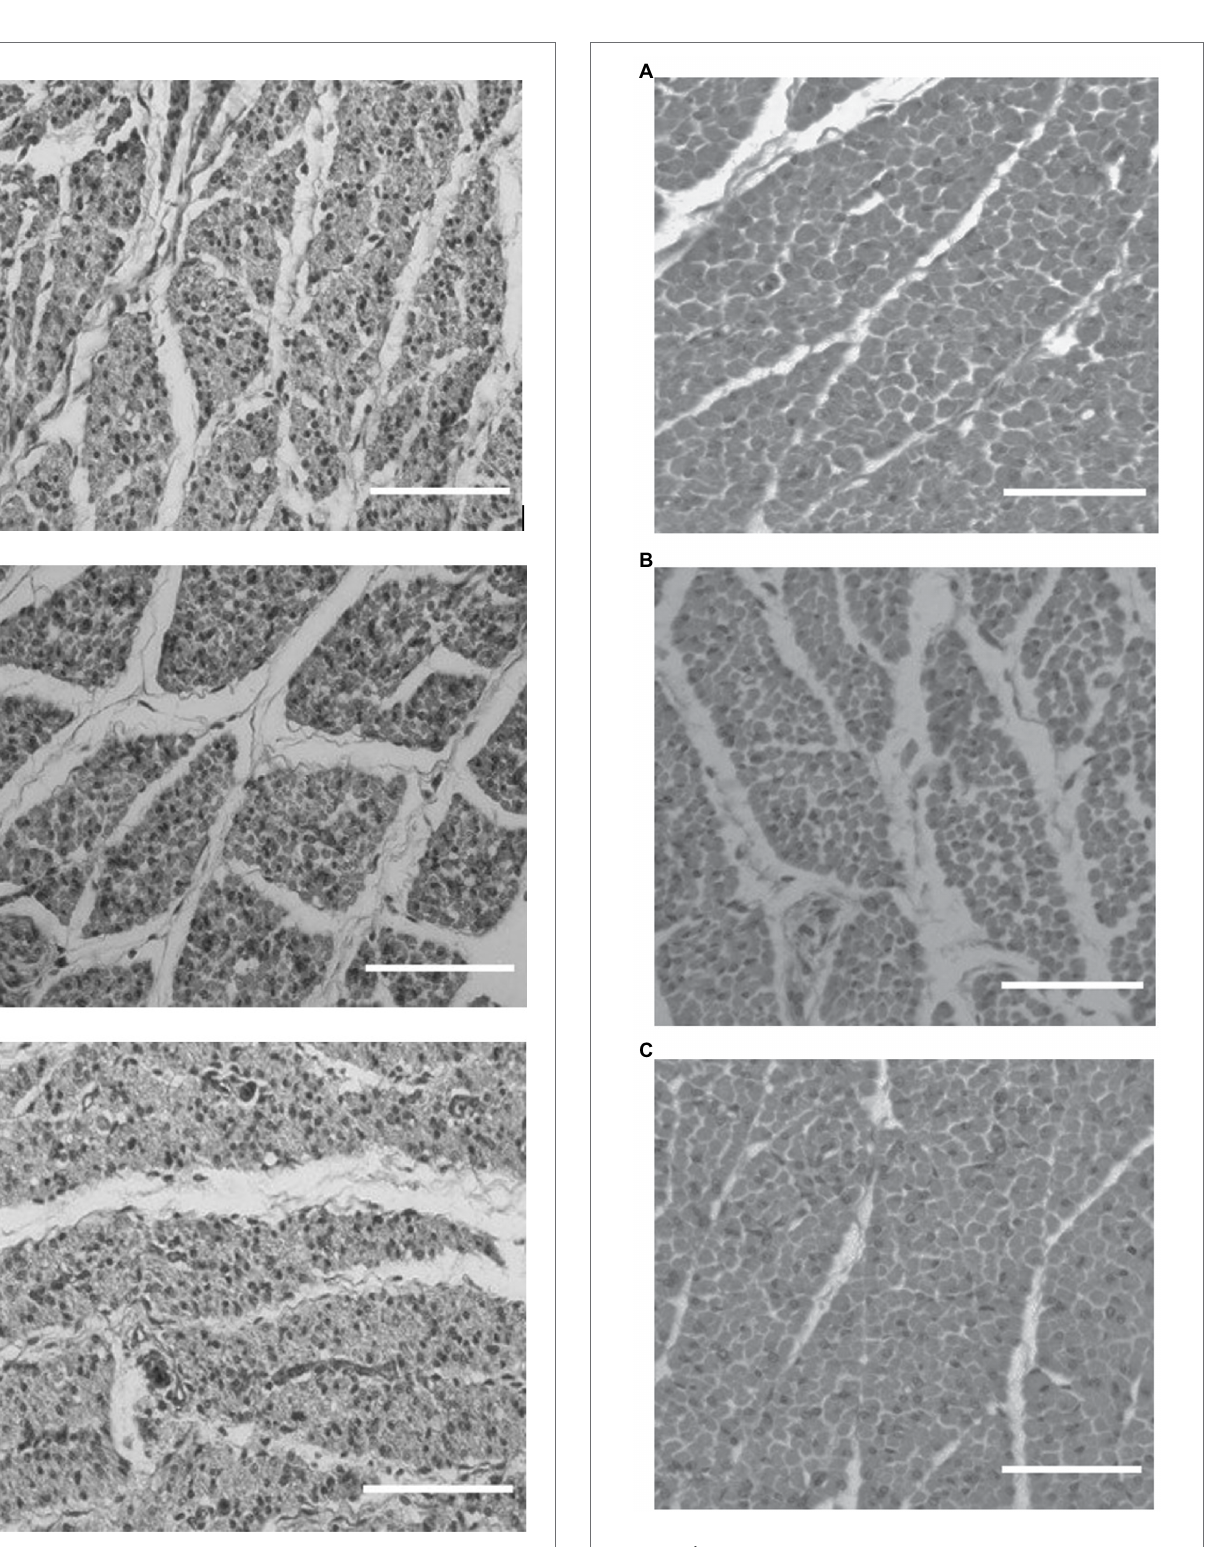
FIGURE 2 | Histology images from the RAN (A) , HBY4 (B) , and LBY4 (C) lines at post-hatch day 4 (selection age) under 40X magnification (Bar = 50 μ m). Different letters indicate significant differences at p < 0.05. RAN-random bred control, HBY4-high percent breast yield at 4 days post- hatch, and LBY4-low percent breast yield at 4 days post-hatch.